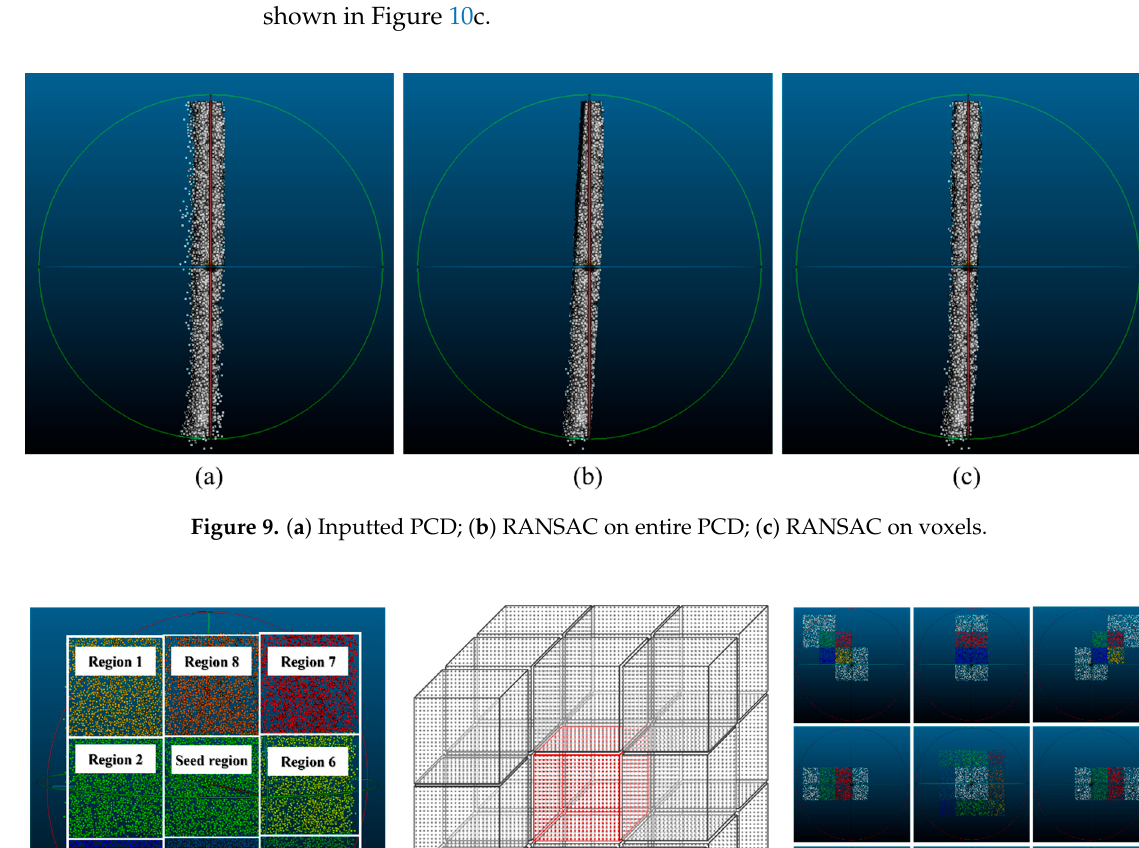
Figure 9. ( a ) Inputted PCD; ( b ) RANSAC on entire PCD; ( c ) RANSAC on voxels.